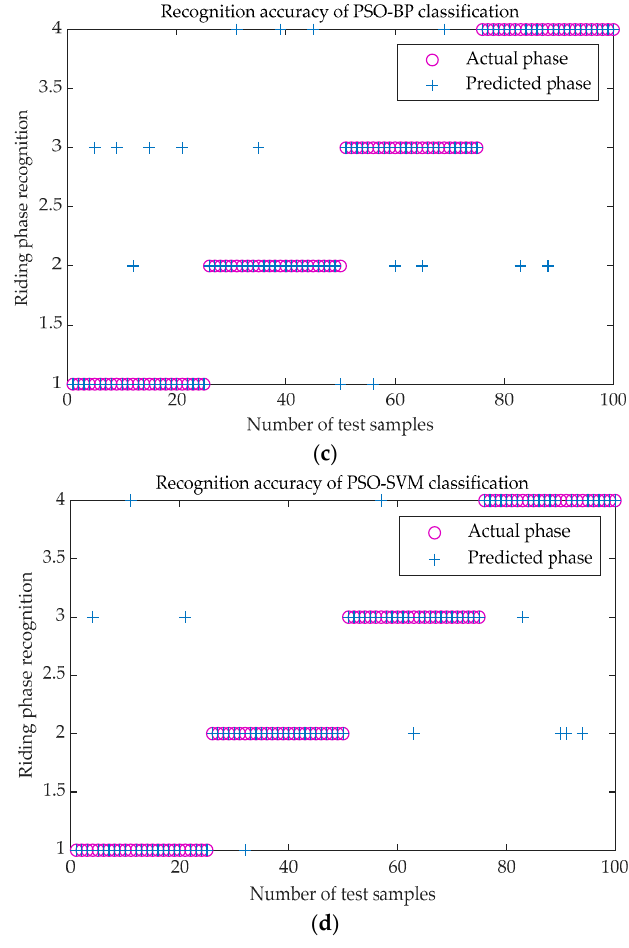
Figure 12. Comparison of recognition accuracy. ( a ) Recognition accuracy of BP classification; ( b ) Recognition accuracy of SVM classification; ( c ) Recognition accuracy of PSO-BP classification; ( d ) Recognition accuracy of PSO-SVM classification.